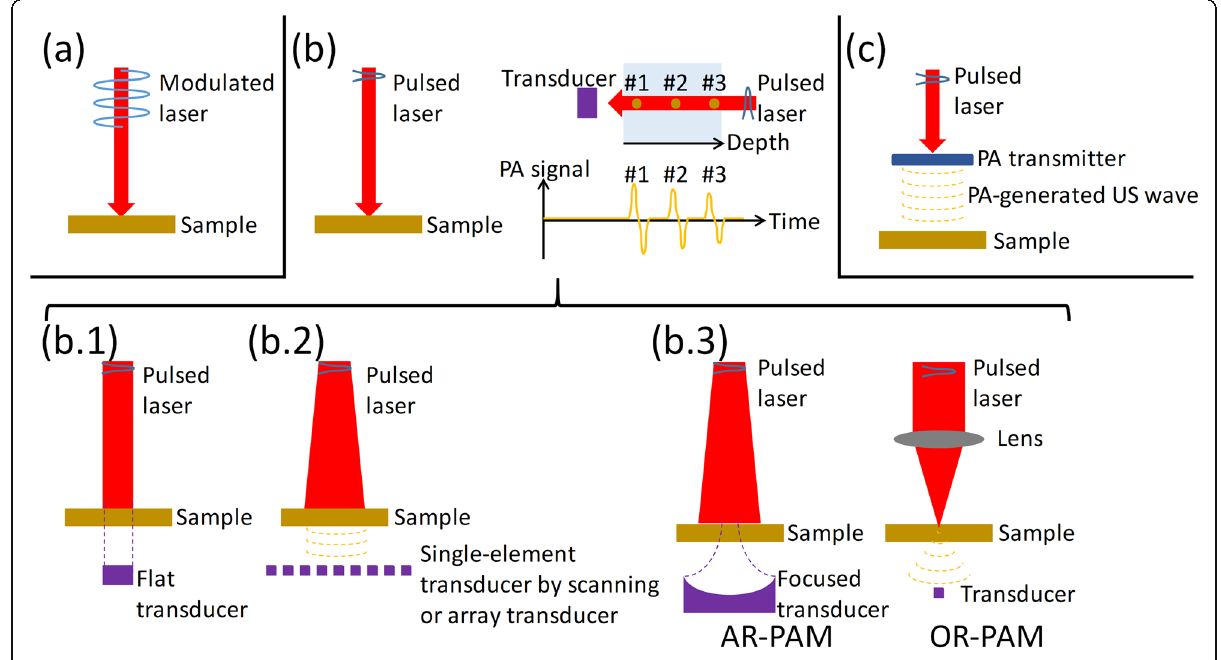
Fig. 1 PA technologies for NDT/E. a : NDT/E with modulated CW laser for PA wave excitation (NDT/E with modulated CW laser for PA wave excitation section); ( b ): NDT/E with pulsed laser for PA wave excitation (NDT/E with pulsed laser for PA wave excitation section) (left) and illustration of the PA A-line signal (right). A flat or focused piezoelectric transducer can be used. (b.1): PA A-line and simple imaging; (b.2): PACT; and (b.3): AR-PAM (left) and OR-PAM (right). In ( b ), transmission mode is plotted for easy illustration. Note that OR-PAM in ( b .3) can also be realized using a modulated CW laser; ( c_ : NDT/E with PA-generated US waves (NDT/E with PA-generated US waves